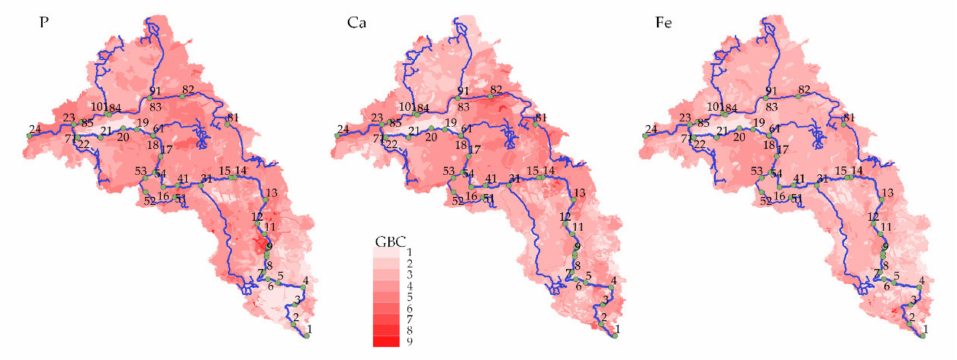
Figure 4. Classes of P, Ca and Fe content (GBC) in the upper layer of soils in the Warta River